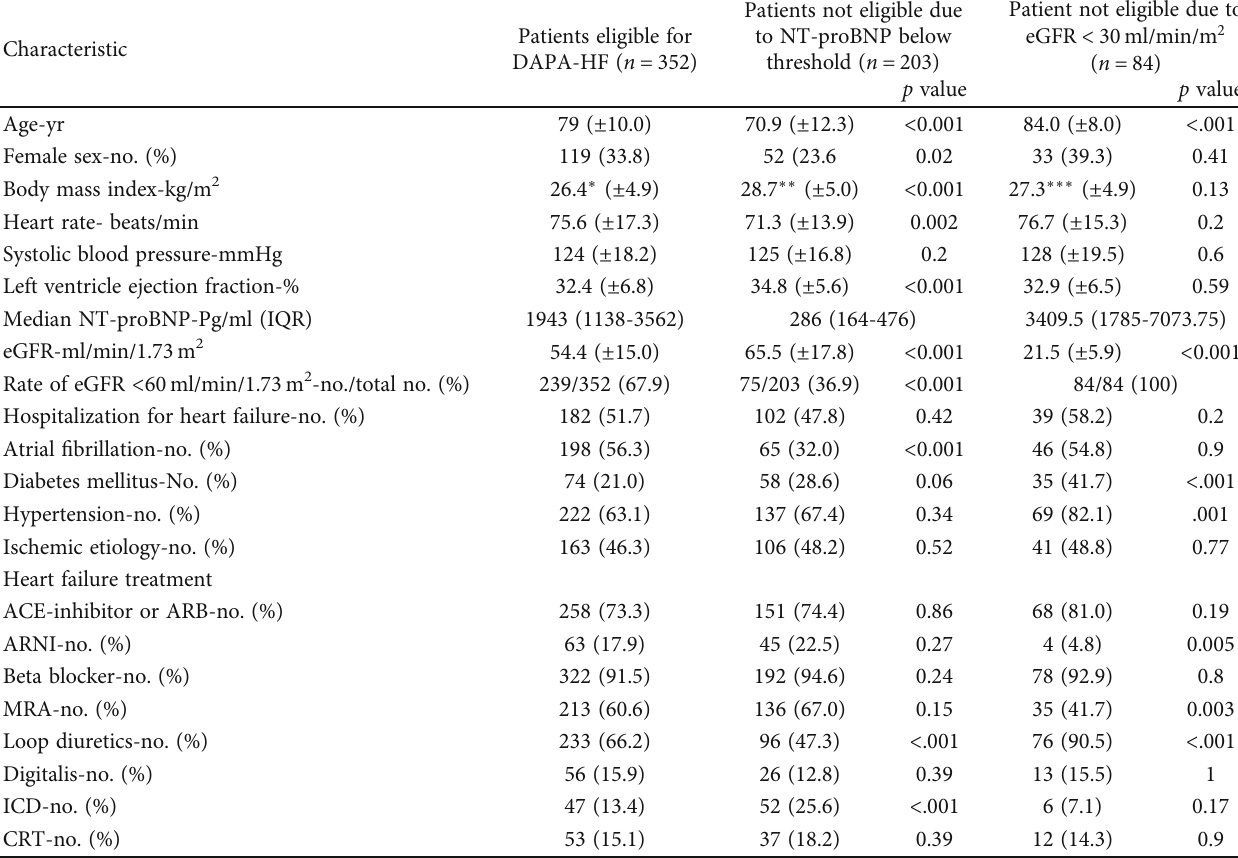
Table 2: Comparison of patients eligible for DAPA-HF compared to ineligible patient according to exclusion criteria.